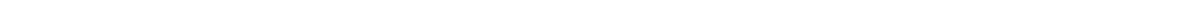
Fig. 7 In vivo neuroprotection by PKD1-Ca from KA-induced hippocampal neuronal death. a Adult male Wistar rats were stereotaxically grafted in the hippocampal CA1 region with GFP (right hemisphere) or PKD-Ca (left hemisphere) lentivirus. (Right panel) Scheme of the KA injection protocol used. After 12 days of lentiviral grafting, rats were treated with saline or KA (8.5 mg per kg, i.p.) and killed 3 days later. b , c Two consecutive brain series were double stained with NF- κ B or NeuN and anti-GFP antibodies to identify transduced neurons in CA1. b Representative confocal images and zoom-boxed regions are shown from saline treated animals ( n = 6 sections per animal, n = 3 animals). c Representative confocal images from right and left CA1 regions in the same slice from an animal treated with KA ( n = 6 sections per animal, n = 4 animals). See zoom-boxed regions for details of nuclear staining of NeuN and NF- κ B, showing it is more preserved in PKD1-Ca-transduced neurons (right panels) compared to the contralateral side GFP-transduced neurons (left panels). d Representative FluoroJade B staining from brain slices showing neuronal death at the CA1 region from saline ( n = 3) and KA-treated ( n = 4) animals. (Right panel) Quanti fi cation of neuronal death as the percentage of FluoroJade B signal in the right or left hemisphere in KA-treated animals ( n = 6 sections per animal, n = 4 animals). Data are expressed as mean + s.e.m. analyzed with two-tailed unpaired Student's t test. ** P < 0.01. e Scheme illustrating the role